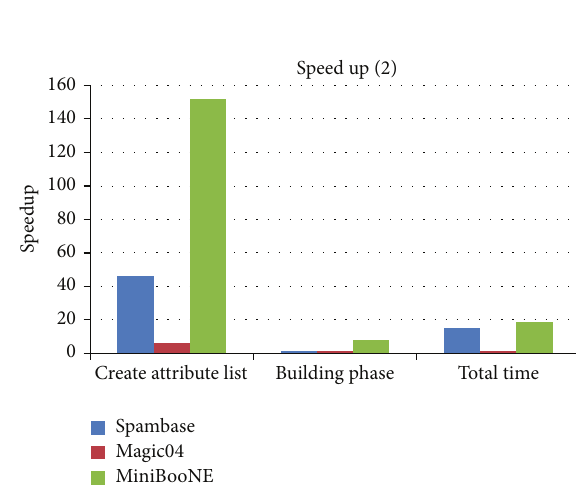
Figure 12: Speedup of each component (1).